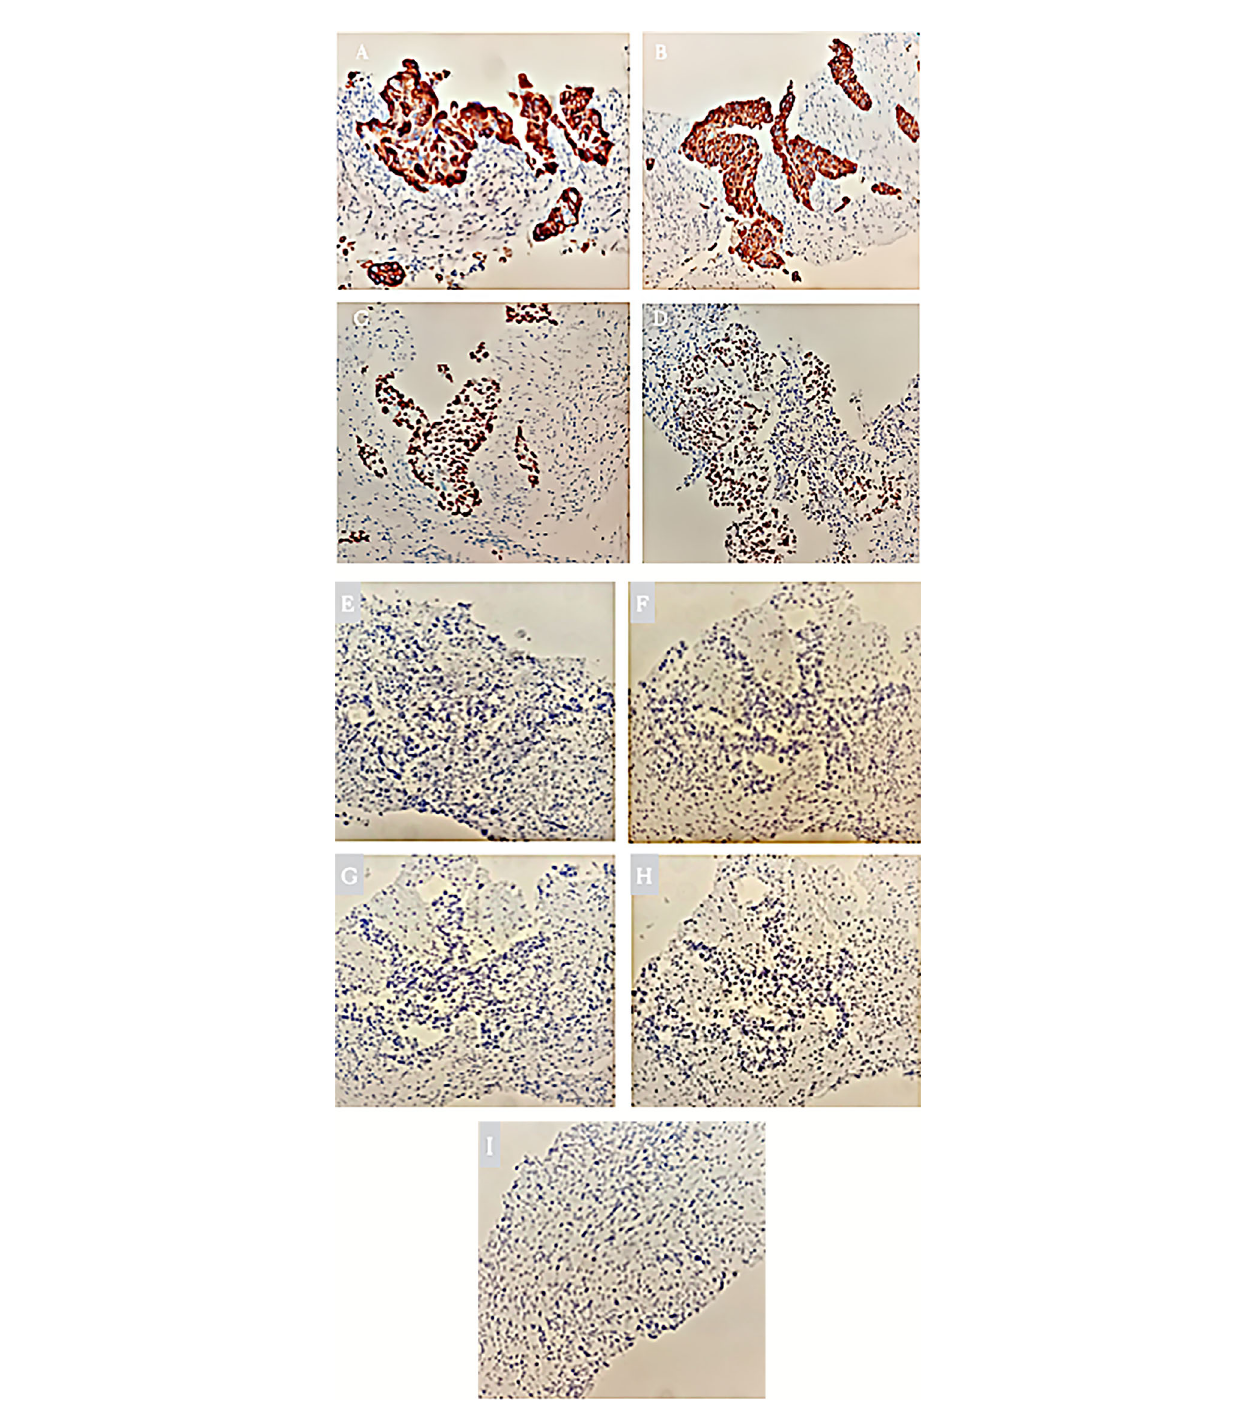
FIGURE 4 | (A) Immunohistochemical staining of CK5/6 expression. Original magni fi cation, x200. (B) Immunohistochemical staining of CK19 expression. Original magni fi cation, x200. (C) Immunohistochemical staining of p63 expression. Original magni fi cation, x200. (D) Immunohistochemical staining of GATA-3 expression. Original magni fi cation, x200. (E) Immunohistochemical staining of negative CK20 expression. Original magni fi cation, x200. (F) Immunohistochemical staining of negative CDX2 expression. Original magni fi cation, x200. (G) Immunohistochemical staining of negative Syn expression. Original magni fi cation, x200. (H) Immunohistochemical staining of negative Cg A expression. Original magni fi cation, x200. (I) Immunohistochemical staining of negative TTF-1 expression. Original magni fi cation,